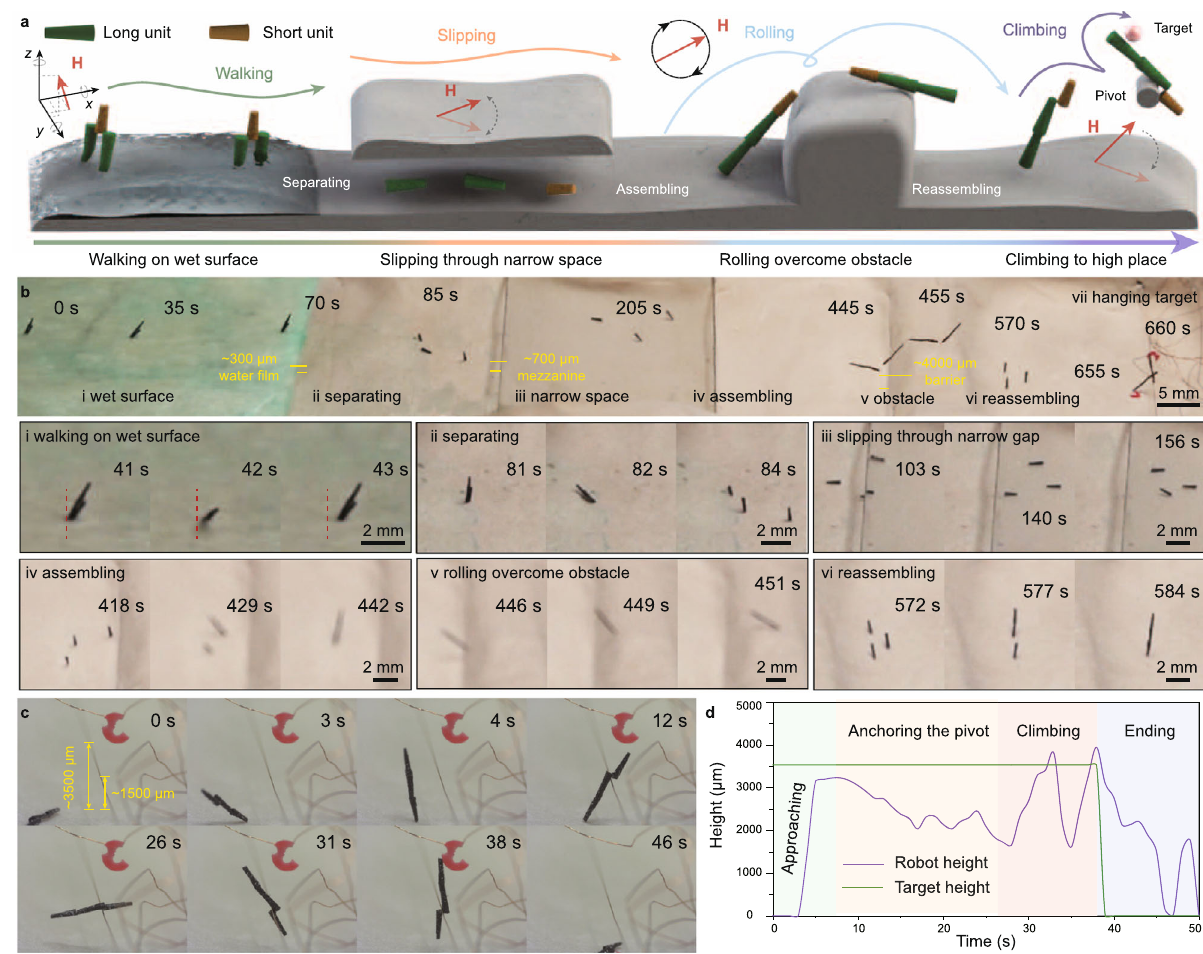
Fig. 5 Combined multimodal locomotion modes of mCEBOT in a compound task. a Schematic diagram of the complexed environment, where mCEBOT starts from the wet surface, and then needs to through a mezzanine and a barrier, fi nally has to take the hanging target. b Experimental results of mCEBOT in the compound task, mainly including walking on wet surface, separating into separated state, slipping through narrow space, assembling into bastinade shape, rolling overcome obstacle, reassembling into hoe shape and taking hanging target. c Time-lapse images of mCEBOT during hanging target taking. d Height changing of mCEBOT and target during the hanging target taking